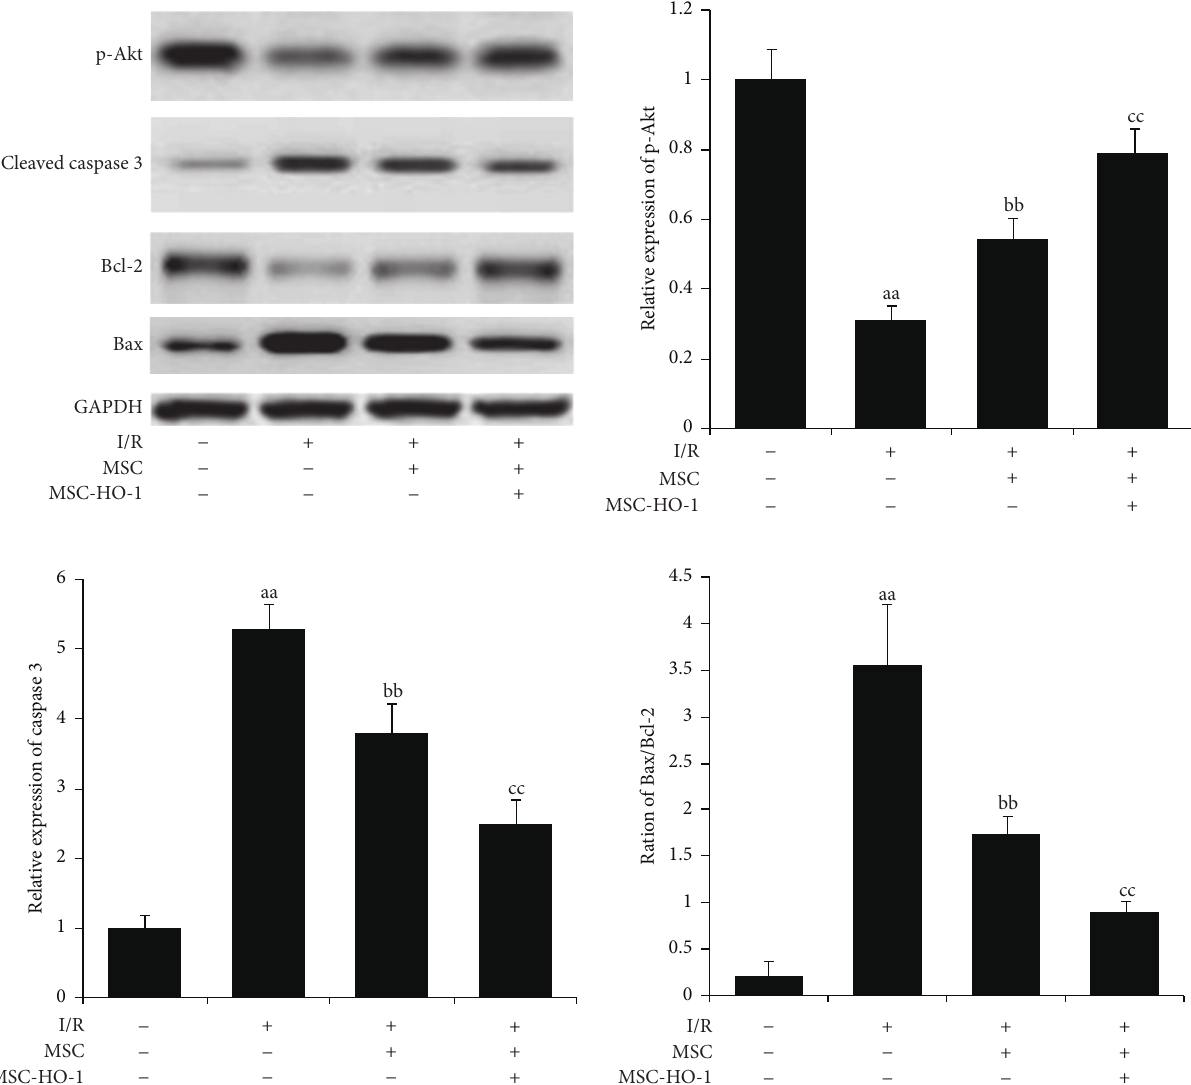
Figure 6: Effects of MSC-HO-1 on the expression of apoptosis-related proteins in retinal cells after I/R injury. At day 21, the expression of apoptosis-related proteins in retinas of control, I/R + PBS, I/R + MSC, or I/R + MSC-HO-1 group was investigated via western blotting ( 𝑛 = 5 ). aa 𝑃 < 0.01 compared with control group; bb 𝑃 < 0.01 compared with IR + PBS group; cc 𝑃 < 0.01 compared with IR + MSC